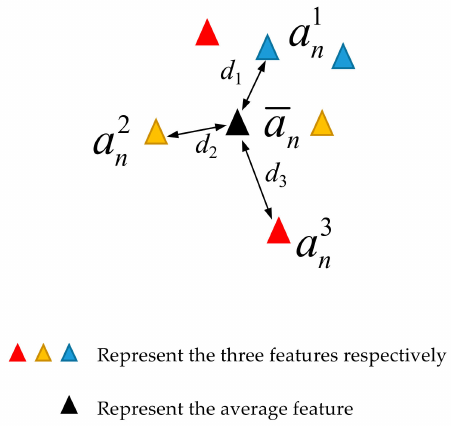
Figure 4. Illustration of the weight